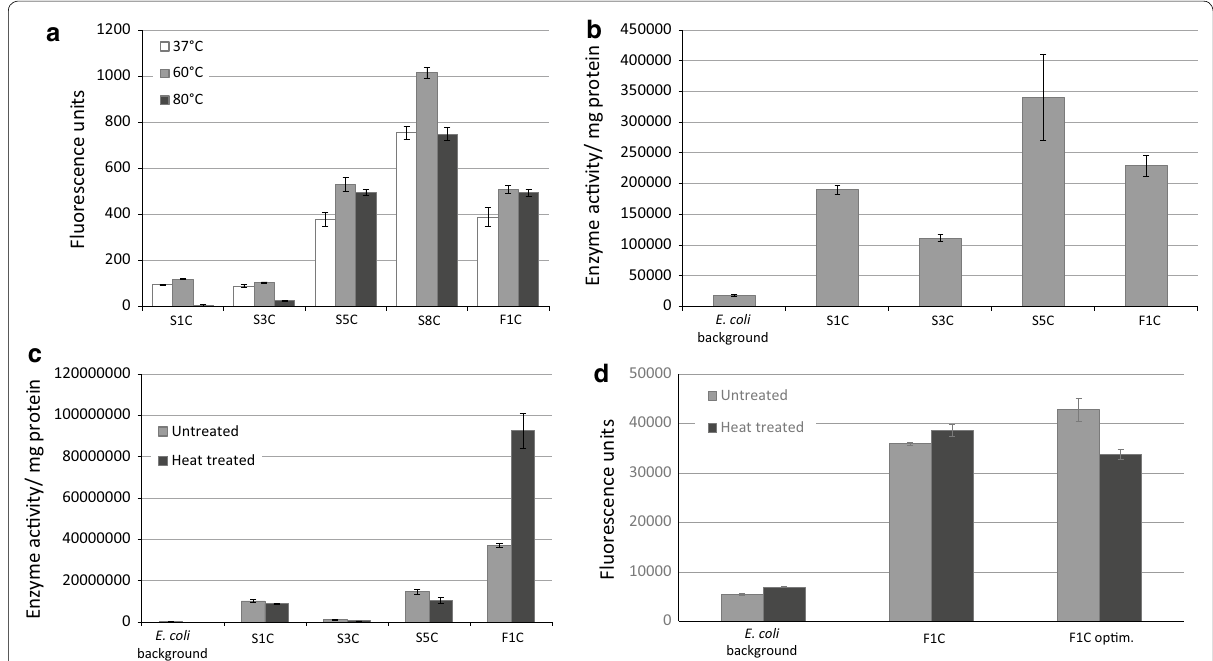
Fig. 5 Activity analysis of cellulases and cellulase fractions measured by quantitative 4-MUC assay. a Analysis of supernatants of cell lysates from four subclones (S1C, S3C, S5C, S8C and F1C), in units of fluorescent signal intensity. The supernatants from each of the four subclones were incu- bated at 37 °C (light grey), 60 °C (medium dark grey) or 80 °C (dark grey), as indicated in figure, for 6 h to test the thermal stability of each respective cellulase. Values for a subclone with different superscripts (a, b, ab) were significantly different ( P < 0.05) by one way ANOVA followed by Turkey multiple comparison. b Activity assay using crude cell extracts, heated at 65 °C for 20 min, with activity/mg protein plotted for extracts originating from E. coli expressing the four cellulase S1C, S3C, S5C, and F1C, in comparison to the E. coli negative control. c Activity assay of the Ni–NTA isolated protein, with activity/mg protein plotted for untreated (medium grey) as well as heat treated (dark grey; 65 °C, 20 min) samples. d Cellulase activity measured in crude cell extract from cells producing native enzyme F1 (F1C), codon optimized enzymes F1 (F1C optim.), as well as from cells not producing enzyme F1 ( E. coli background). All samples were analysed with and without heat treatment (65 °C, 20 min). Error bars represent standard deviations from three independent